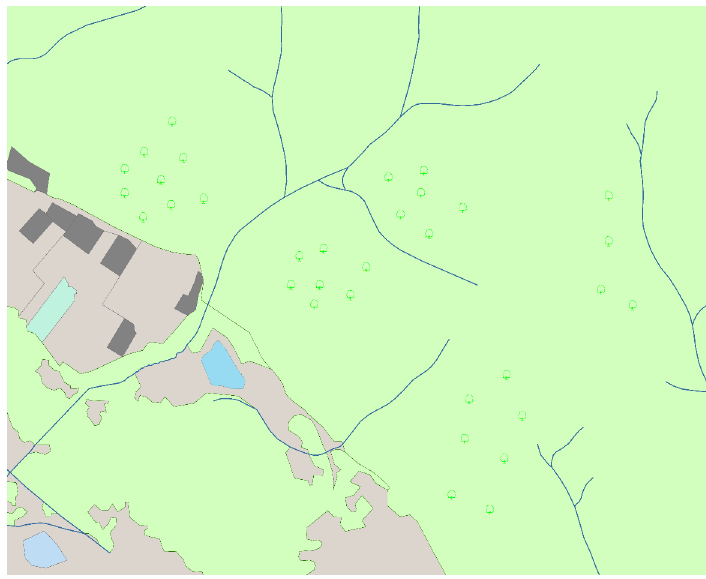
Figure 4. Point features (trees) represented with minimum colour dimensions using perception coefficient ( P c = 1.64).